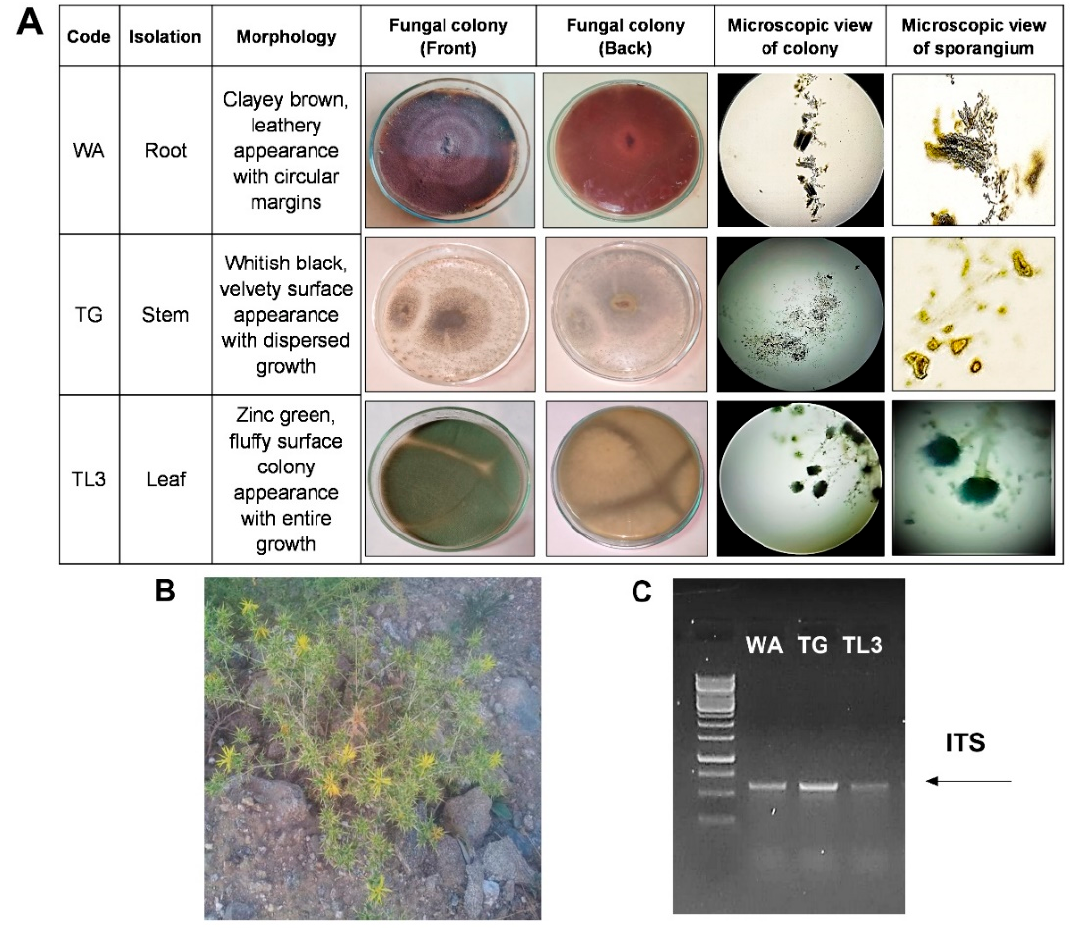
Figure 1. ( A ) Morphological characterization of selected fungal strains WA, TG, and TL3, ( B ) Xerophytic plant ( Carthymus oxycantha L.) selected for isolation, and ( C ) genotyping of selected fungal strains by ITS region amplification.